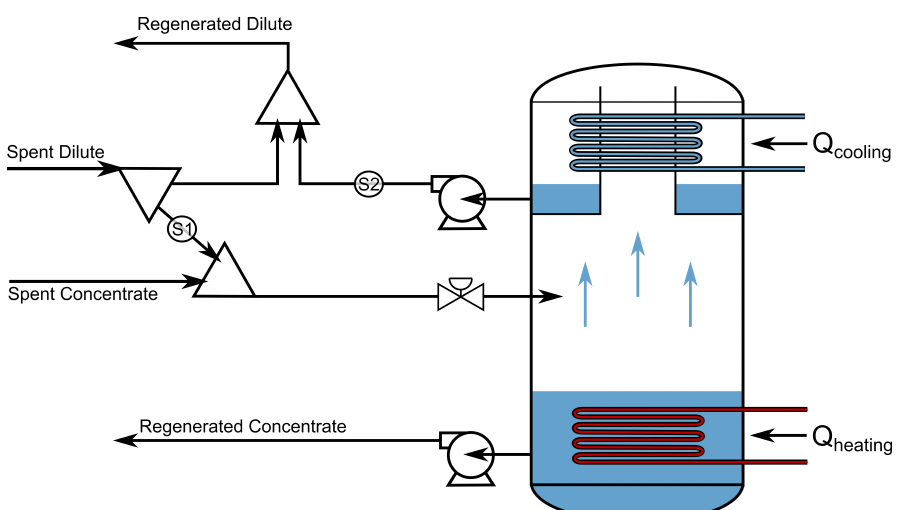
Figure 2. Conceptual sketch of the evaporation regeneration stage with spent dilute and concentrate coming from the outlet of the RED stack. Pumps required for solution propulsion are not shown, only pumps related to the vacuum circuit. All salt that passes the membranes to the dilute side of the RED stack is returned to the concentrate side through S 1, bringing some water along. Any excess water on the concentrate side is evaporated and added to the dilute side through S 2.